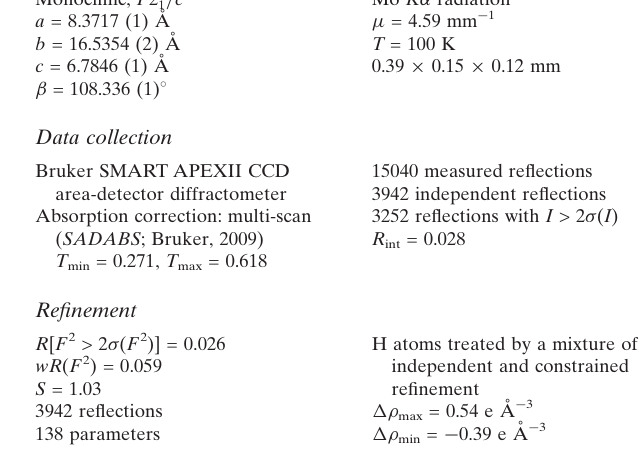
Data collection Bruker SMART APEXII CCD area-detector diffractometer Absorption correction: multi-scan ( SADABS ; Bruker, 2009)